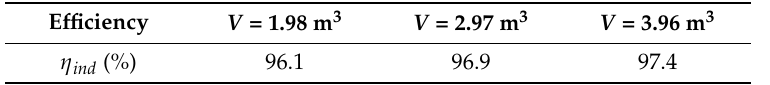
Table 6. Efficiency system for the second configuration varying the Volume of the